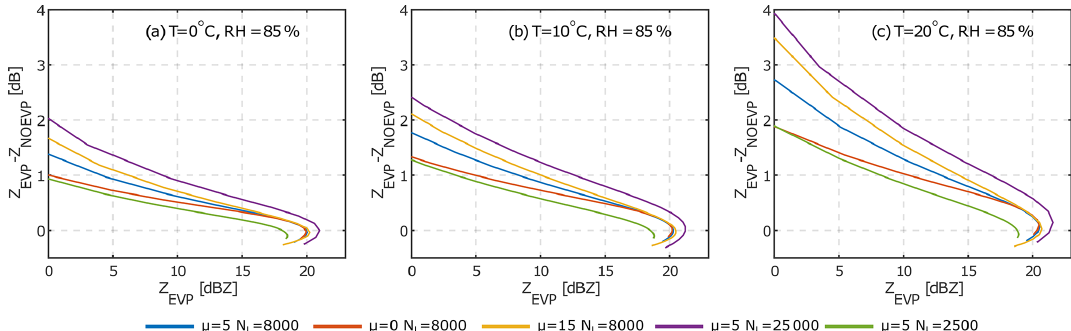
Figure 16. Simulated impact of evaporation on the simulated reflectivity at a 250m range for DSDs measured at the surface. Z NOEVP is the reflectivity at a 250m range calculated with DSDs assumed at the surface, without taking evaporation into account. Z EVP is the reflectivity at a 250m range assumed for the same surface rain DSDs but corrected for drop evaporation within the 250m layer. For the shown evaporation scenario, surface temperature and humidity are assumed to be 10 ◦ C and 85%, respectively. The colors denote simulations with different rain DSD parameters. The effect of bending at Z EVP values around 20dBZ results from a faster increase in attenuation, with a rain rate relative to nonattenuated reflectivity (Hogan et al.,